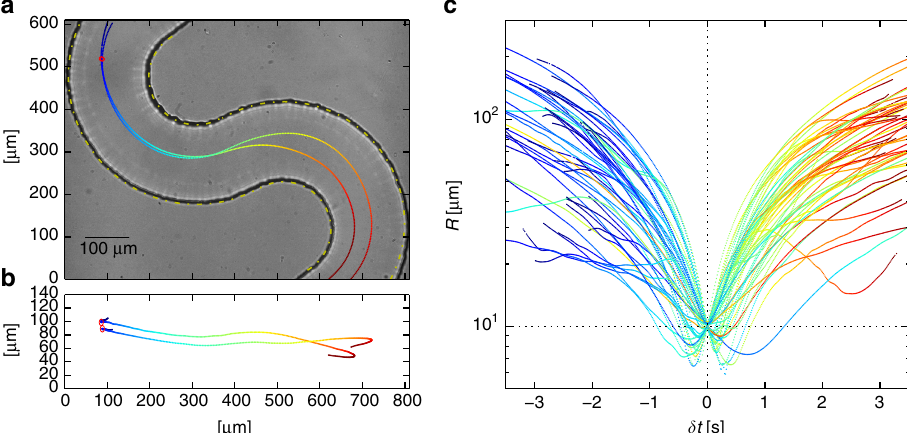
Fig. 1 Pair dynamics example. The trajectories of two tracers are plotted in the left panels . The right panel shows a sub-sample of pair separation distances in the course of time. The fi gure outlines the analysis forming the ensembles of pairs, as well as demonstrates the chaotic nature of the fl ow as manifested by pairs; to develop the intuition and contrast with laminar fl ow, the reader is referred to, e.g., (Figs. 21 – 22 of ref. 9 ); several features of the mean fl ow in our case are manifested in the Eulerian representation in Supplementary Fig. 2, particularly the striking differences from Poiseuille-like laminar fl ows. a A projection on to the plane of the camera, which is imaging the channel from the bottom side (gravity pointing out of the panel towards the reader), overlaid on a bright fi eld image of the observation window (further technical details are provided in Supplementary Fig. 1 and in the Methods section). b A side projection; the vertical axis is aligned with that of gravity, as well as the channel depth, 0 μ m marking the channel bottom plane; as the width of this panel spans a spatial range which is nearly six times longer than its height, for the sake of visualisation the vertical axis is stretched by 3/2; the colour code in the plot denotes time, which spans 4 s in this case. All pairs of tracers which were detected at some instant at a prescribed separation distance, R 0 = 10 ± 0.5 μ m in this particular example, are collected to form one ensemble. The event at which the pair separation was nearest to R 0 , marked by the red circles in the plot, is recorded as t 0 for the speci fi c pair for later analysis. Each R 0 bin is 1 μ m wide and centred at 6 through 50 μ m, with sample sizes ranging from nearly 10 4 to over 10 6 pairs, respectively; sample size data are presented in Supplementary Fig. 6. c A sub-sample of pair separation distances R ( δ t ) for 49 pairs belonging to the R 0 = 10 μ m ensemble, presented on a semi-logarithmic scale; for each pair, δ t = t − t 0 is the time elapsed since t 0 . The colour code denotes time, scaled separately for each